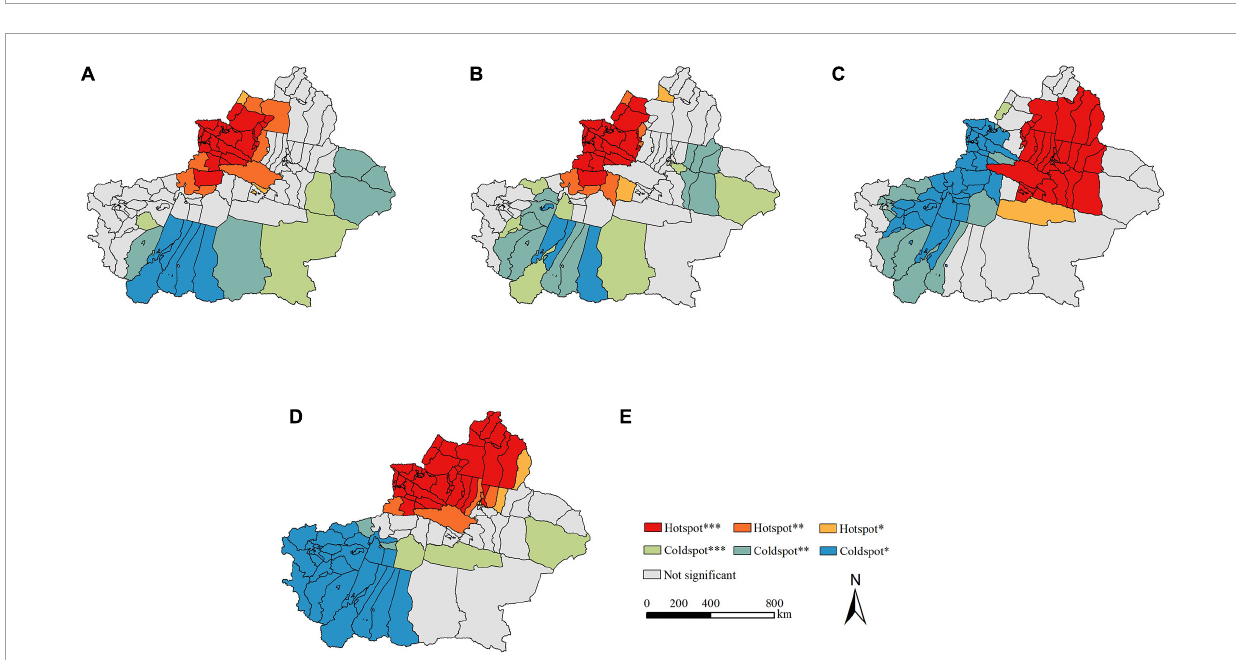
FIGURE3 Spatial distribution of ecosystem service hotspots and coldspots. The statistical significance is shown as follows: (1) ∗∗∗ refers to the 99% confidence level; (2) ∗∗ refers to the 95% confidence level, and (3) ∗ represents the 90% confidence level. (A–D) Carbon storage, Habitat quality, Sand fixation, and Water yield. (E)